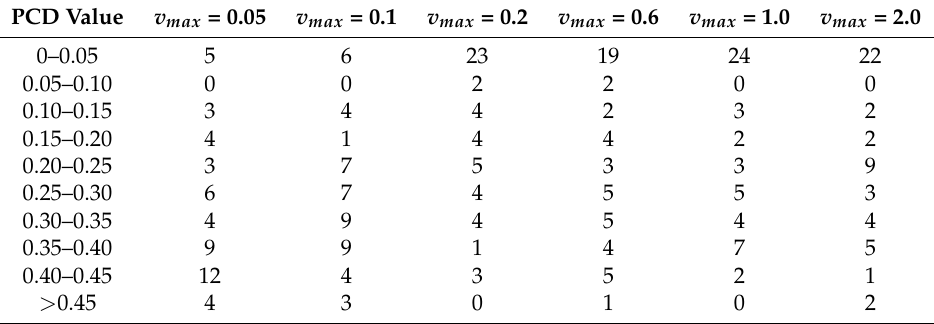
Table 2. Number of statistical cases of the PCD value evaluated from the final node deployment by the VFA-SF for different values of v max